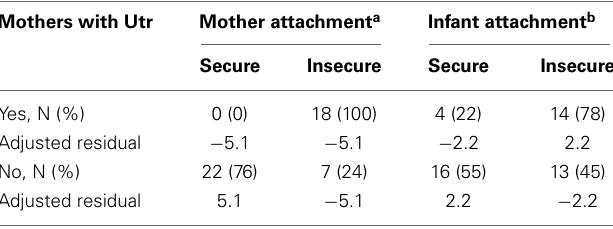
Table 2 | Adult and infant attachment classifications in mothers with and without unresolved trauma